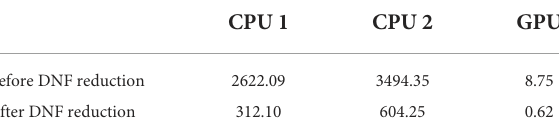
Table 1 Execution time (in seconds) of the 3-dimensional PDE solver Magnolia implementation compiled to C ++ , with and without reduction to